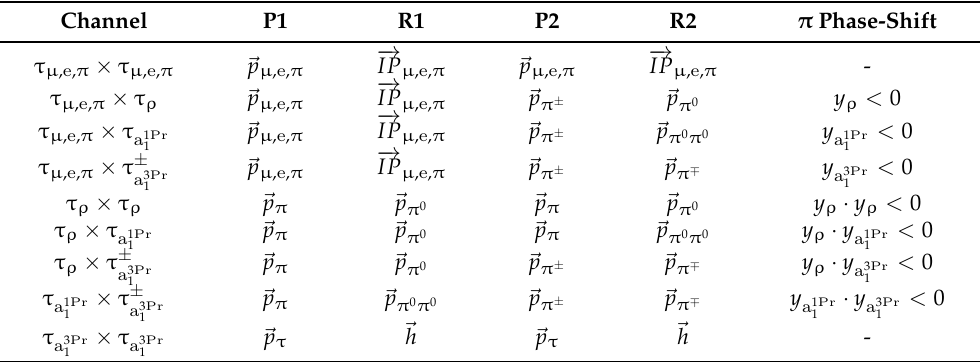
Table 2. Summary of the vectors used to reconstruct the acoplanarity angle in the decay channels analyzed in [18,26,28]. Note that for τ a 3 Pr decays the sign is written explicitly to identify the pion 1 having the same sign as the decaying τ lepton, and the one having the opposite sign. Channel